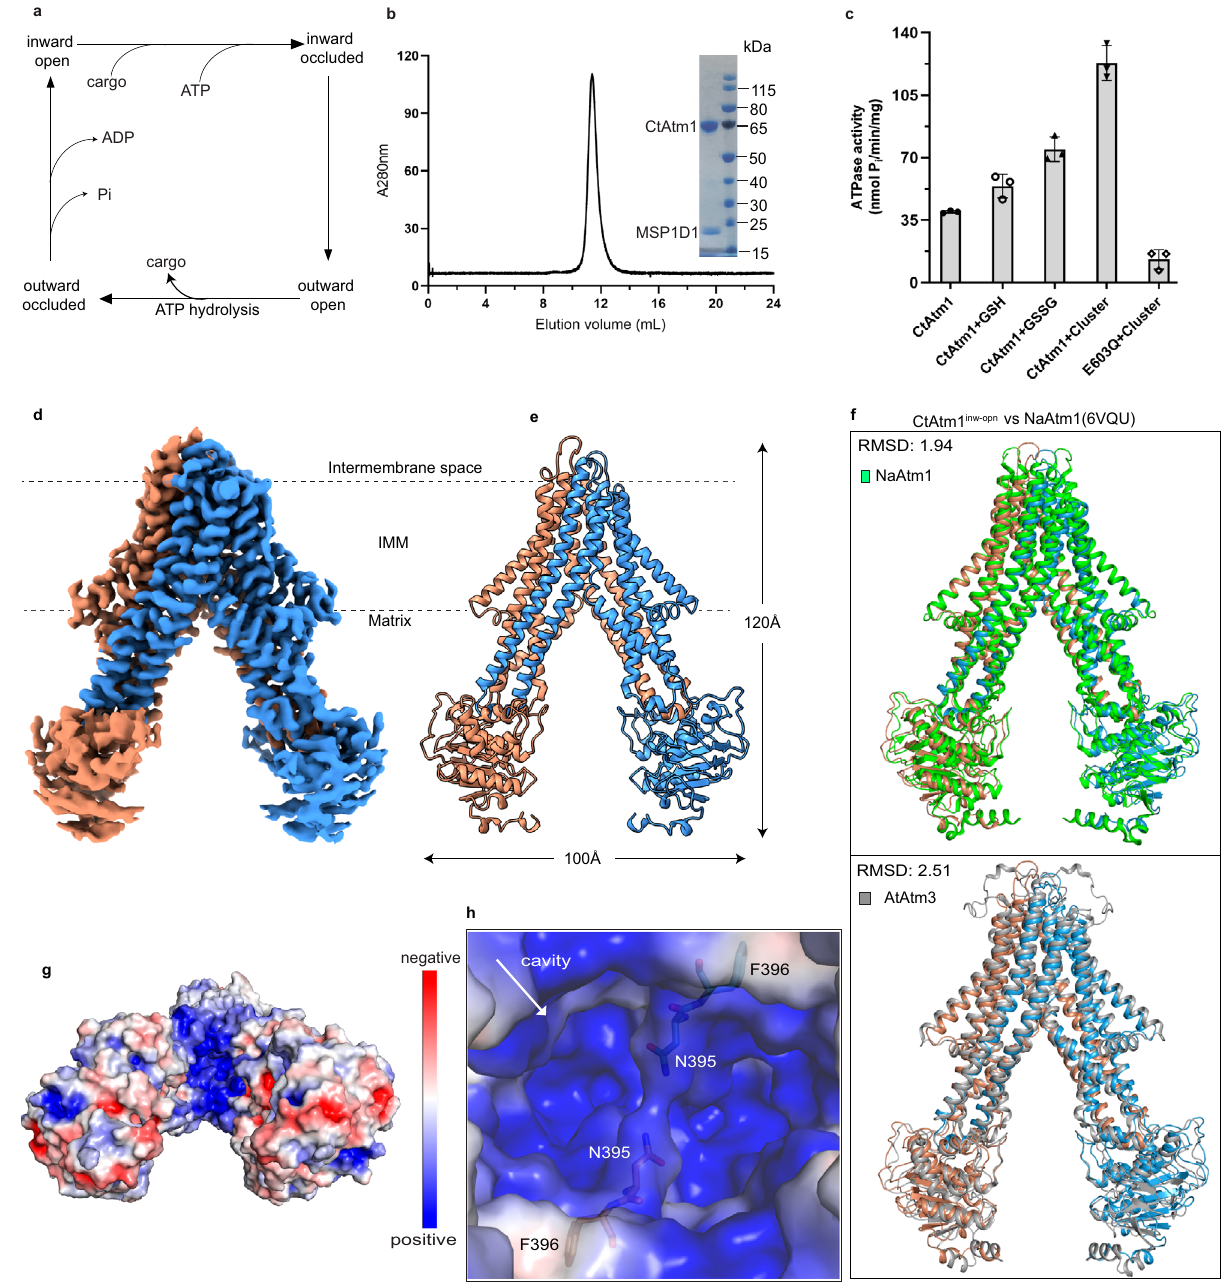
Fig. 1 | Transport cycle, function, and inward-open structure. a Atm1-type ABC proteins presumably exploit a transport mechanism that includes inward-facing, occluded, outward-facing, and closed conformations, and requires ATP and cargo to turnover. b CtAtm1-discs size-exclusion chromatography pro fi le and associated Coomassie-stained SDS-PAGE analysis (nanodisc reconstitutions were performed more than three independent times). c ATPase activity of CtAtm1 in detergent solutionand20 µ MGSH,GSSG,orcluster.Datapointsrepresentthemeansofthree independentmeasurementsand errorbarsindicate standarddeviation. d Cryo-EM